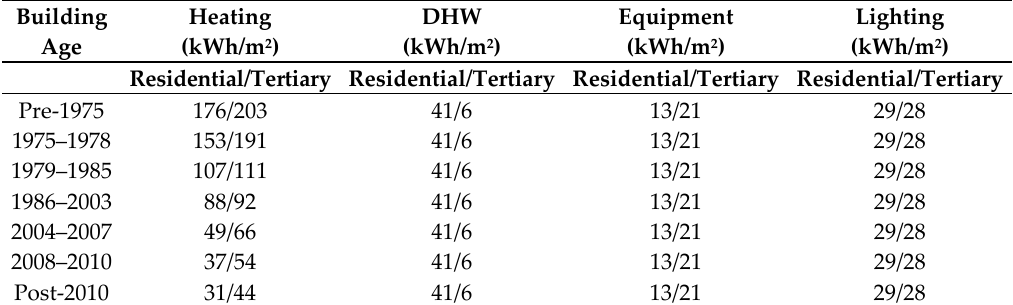
Table 1. Modelling results (heating, DHW and electricity demand) for the buildings of Helsinki.